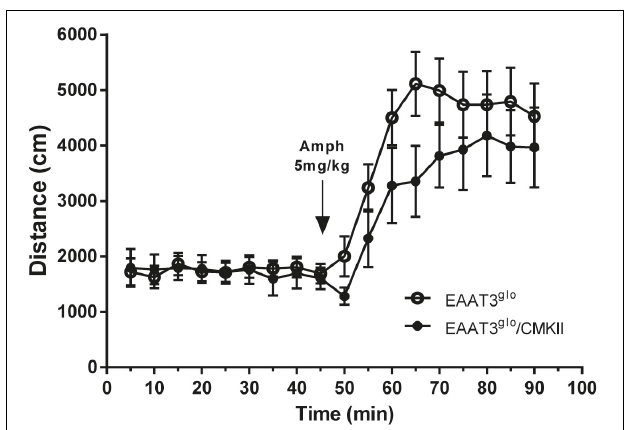
FIGURE 2 | Basal and amphetamine-induced locomotion is unaltered in EAAT3 glo /CMKII mice. Mice were placed in an open-field arena (40 × 40 × 35 cm) and their horizontal trajectory was video recorded in basal conditions and after acute amphetamine (5 mg/kg s.c.). Graph shows the cumulative distance traveled by mice in 5 min blocks during 45 min before and after amphetamine. EAAT3 glo n = 11 (6M, 5F); EAAT3 glo /CMKII n = 8 (5M, 3F).